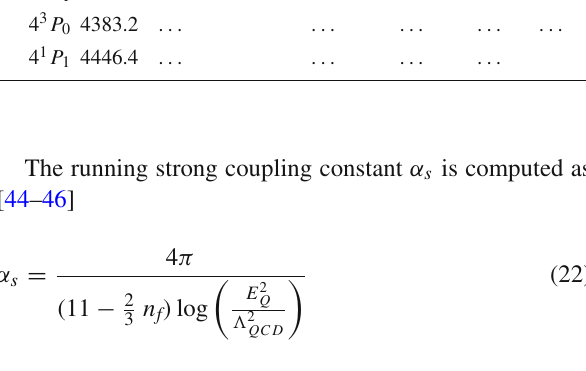
with n f = 3 and (cid:15) QCD = 0 . 250 GeV for charmonium and n f = 4 and (cid:15) = 0 . 156 GeV for bottomonium. In Eq. QCD